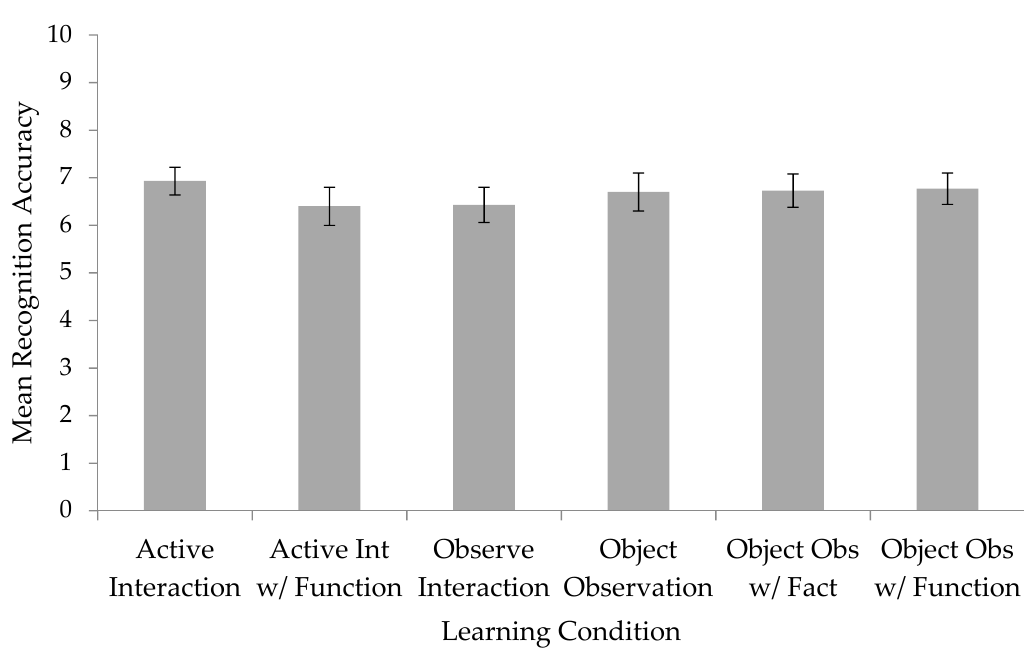
Figure 1. Mean recognition accuracy for children in each of the six learning conditions in Experiment 1. Error bars represent standard errors.